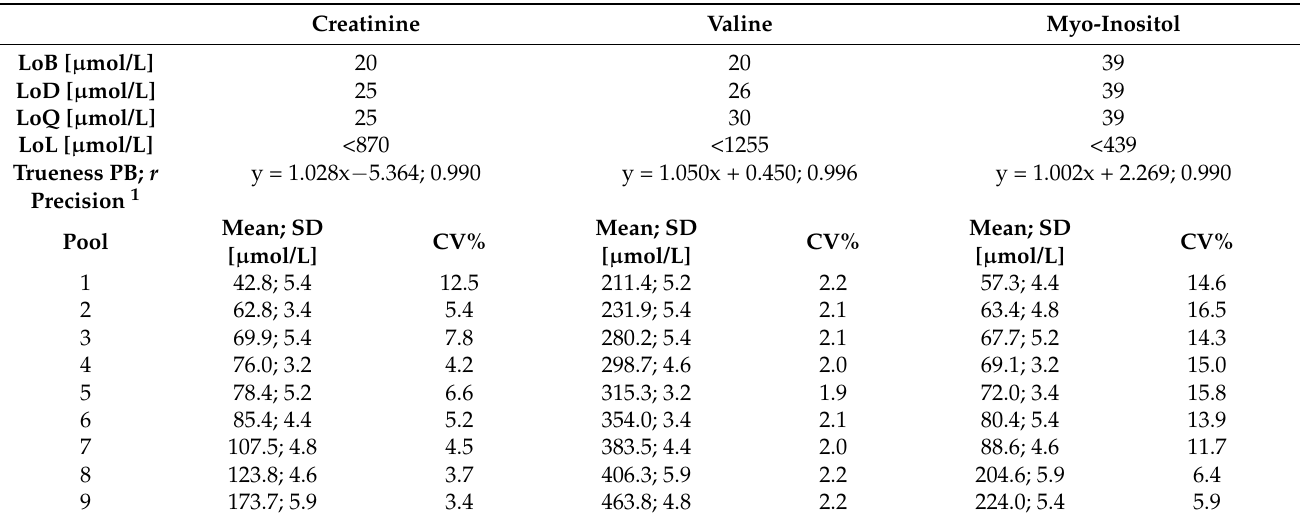
1 Single-site within-laboratory precision (1 site × 9 serum pools × 3 replicates per pool × 2 runs per day × 20 days; N = 1080 measurements). The nine serum pools were chosen to cover low to high physiological concentrations of the respective metabolites. Abbreviations: LoB, limit of blank; LoD, limit of detection; LoQ, limit of quantification; LoL, upper limit of linear range; r , Pearson correlation coefficient; PB, Passing-Bablok regression; CV%, coefficient of variation (for within-laboratory pre- cision) (%).